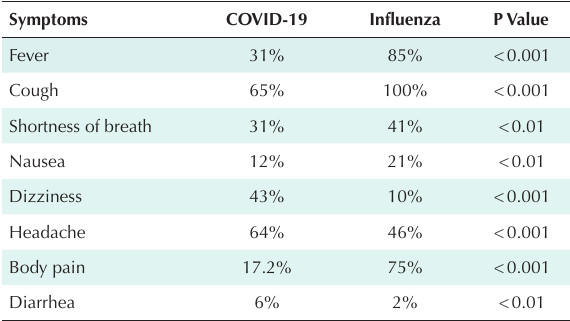
Table 1. Clinical Symptom in COVID-19 and Influenza Patients